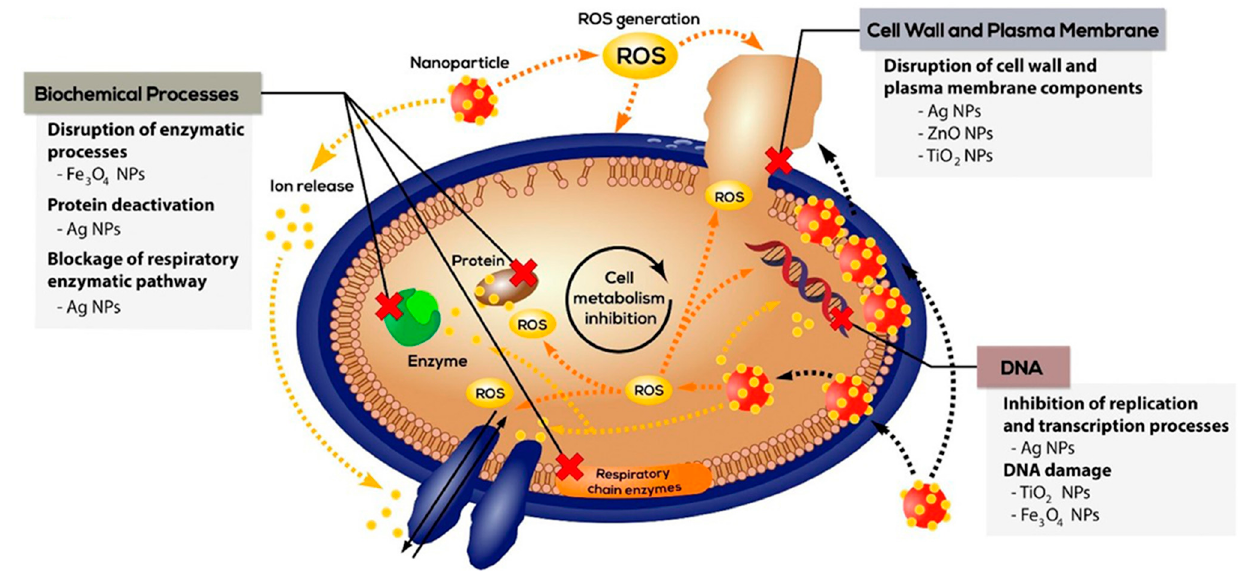
Figure 6. Various mechanisms suggested for the killing function of antibacterial nanoparticles [46]. Reprinted from an open-access source.